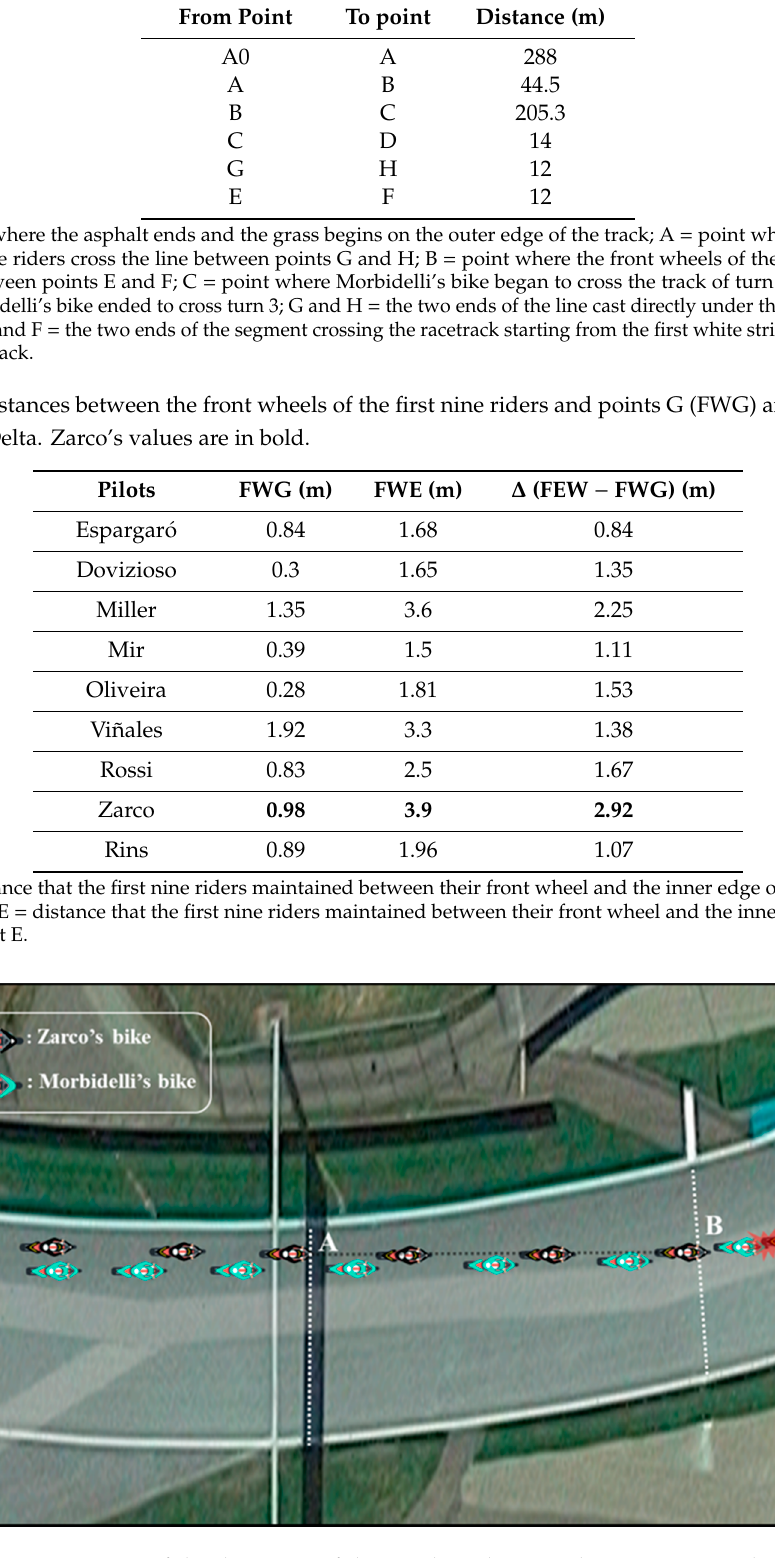
Figure 7. Representation of the dynamics of the accident showing that Zarco crossed Morbidelli’s trajectory immediately after overtaking him as he moved towards the center of the track.